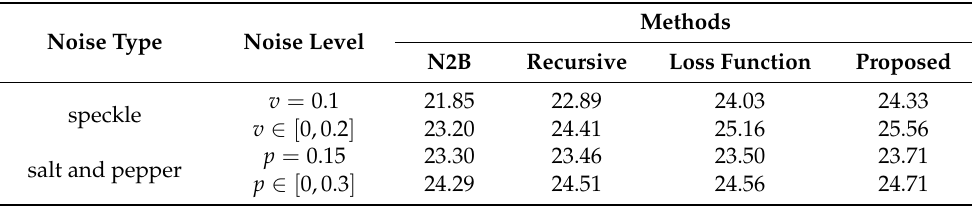
Table 7. Comparison of denoising performance according to speckle, and salt and pepper